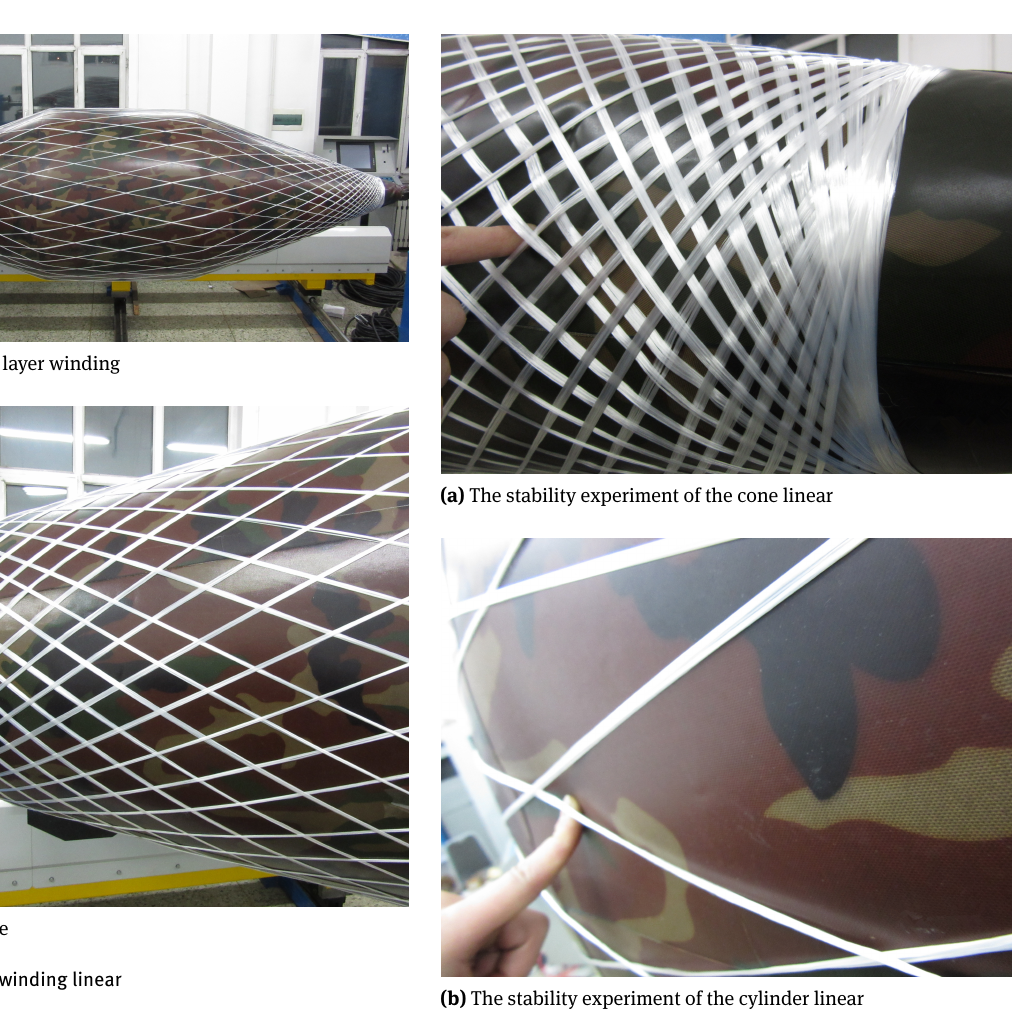
Figure 12: Stability experiment of winding linear